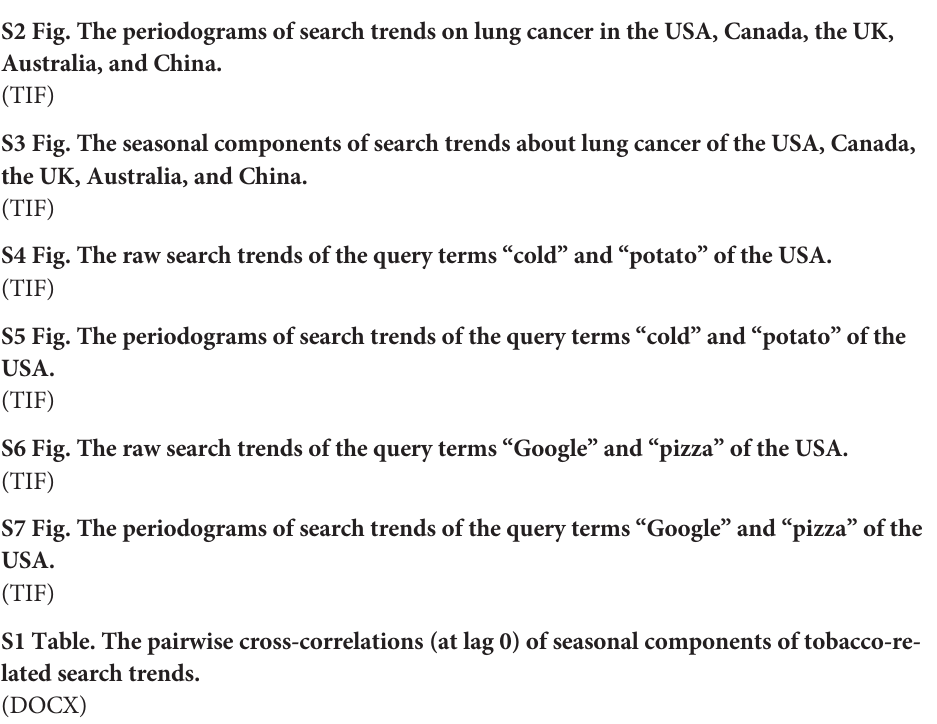
S4 Fig. The raw search trends of the query terms “ cold ” and “ potato ” of the USA. S5 Fig. The periodograms of search trends of the query terms “ cold ” and “ potato ” of the USA. S6 Fig. The raw search trends of the query terms “ Google ” and “ pizza ” of the USA. (TIF) S7 Fig. The periodograms of search trends of the query terms “ Google ” and “ pizza ” of the USA. S1 Table. The pairwise cross-correlations (at lag 0) of seasonal components of tobacco-re- lated search trends. S2 Table. The pairwise cross-correlations (at lag 0) of seasonal components of search trends regarding lung